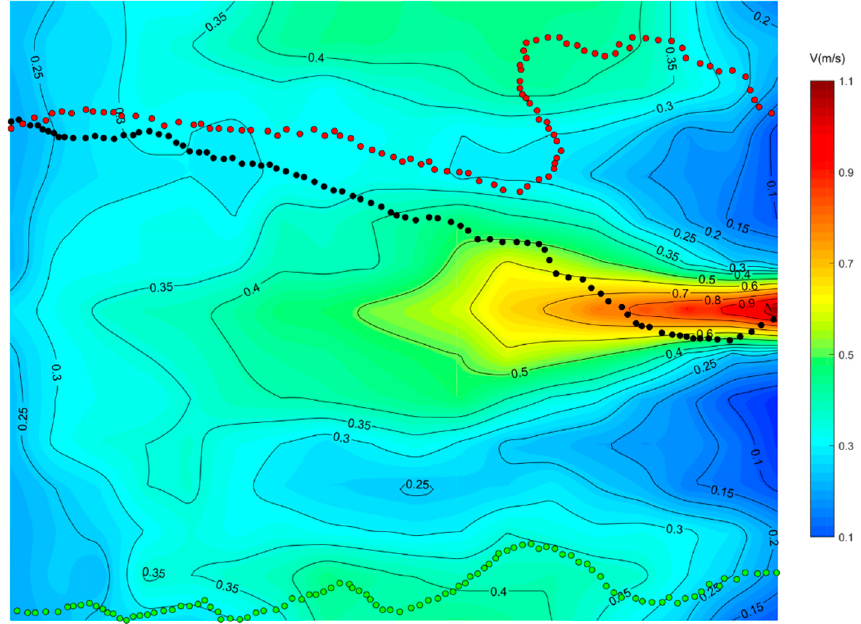
Figure 6. Superposition of representative travel trajectory and flow field in a single-peak outflow condition focused observation cell.